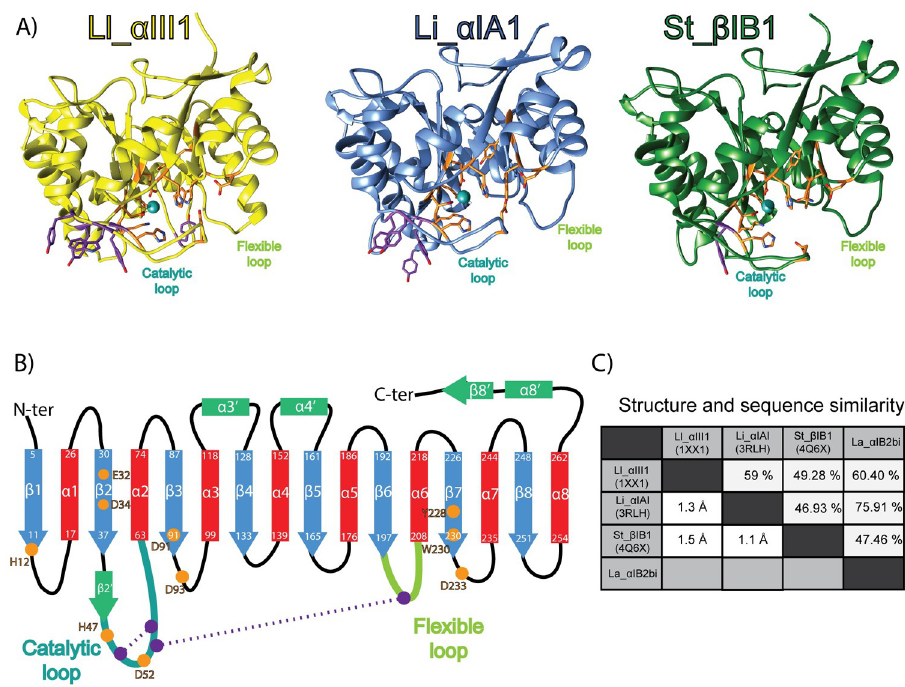
Fig 1. Overview of the SicTox PLD structures. A) Structures of phospholipases D used in this work. Li_ α III1, Li_ α IA1 and St_ β IB1 are represented in yellow, blue and green, respectively. The side chains of amino acids critical for substrate binding and catalysis are shown in orange. The aromatic residues located at the putative i-face are indicated in purple. B) PLD topology: strands (blue) and helices (red) of canonical ( α / β ) 8 barrel, other secondary structure elements (green), catalytic loop (cyan), flexible loop (green), disulphide bridges (purple). Residue numbering is based on the Li_ α IA1 structure (PDB id: 3RLH). C) Structure and sequence similarity: pairwise RMSD (lower left triangle) and sequence similarity (upper right